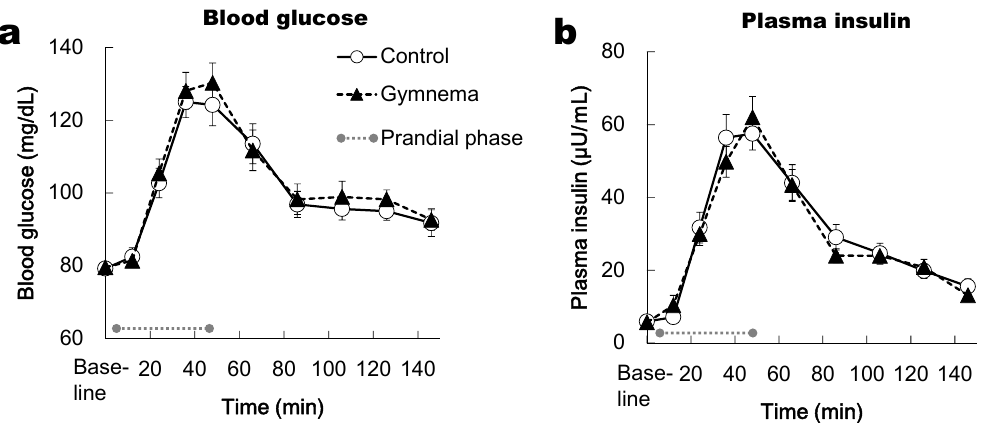
Figure 4. Time courses of blood glucose ( a ) and plasma insulin ( b ) responses during prandial and postprandial phases. Mean ± SE. Grey circles at both ends of the dotted gray line denote the limits of the prandial phase (consumption of sweet-tasting food).